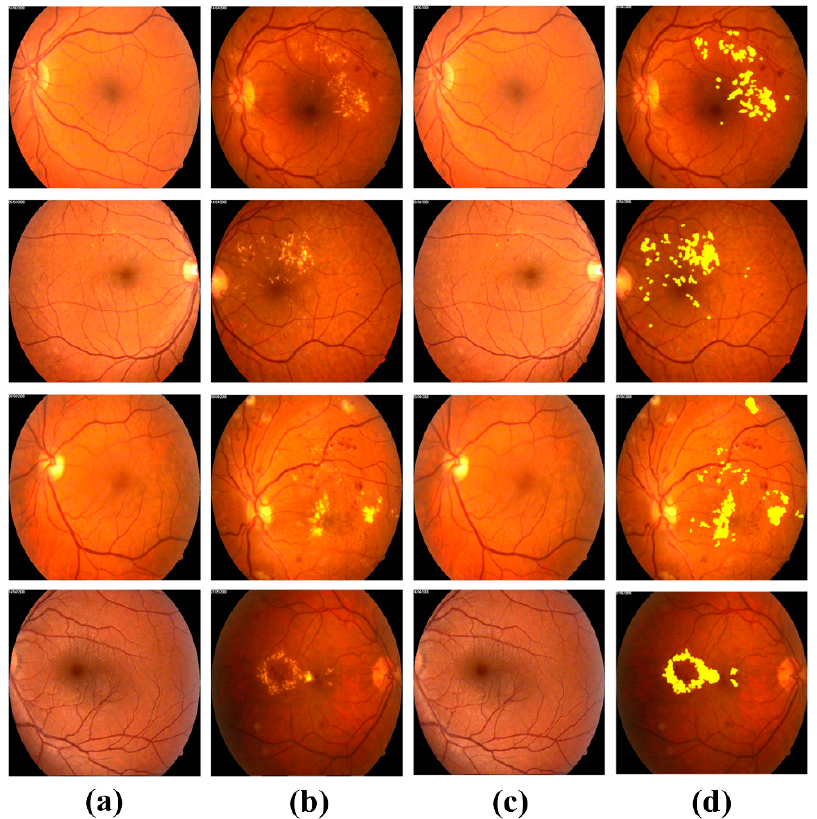
Figure 15. Healthy and ME fundus scans in the Rabbani Dataset [39,40], which are processed by the proposed system. ( a ) Original healthy fundus scans; ( b ) original ME fundus scans; ( c ) classified as healthy by the proposed system and ( d ) classified as ME by the proposed system.